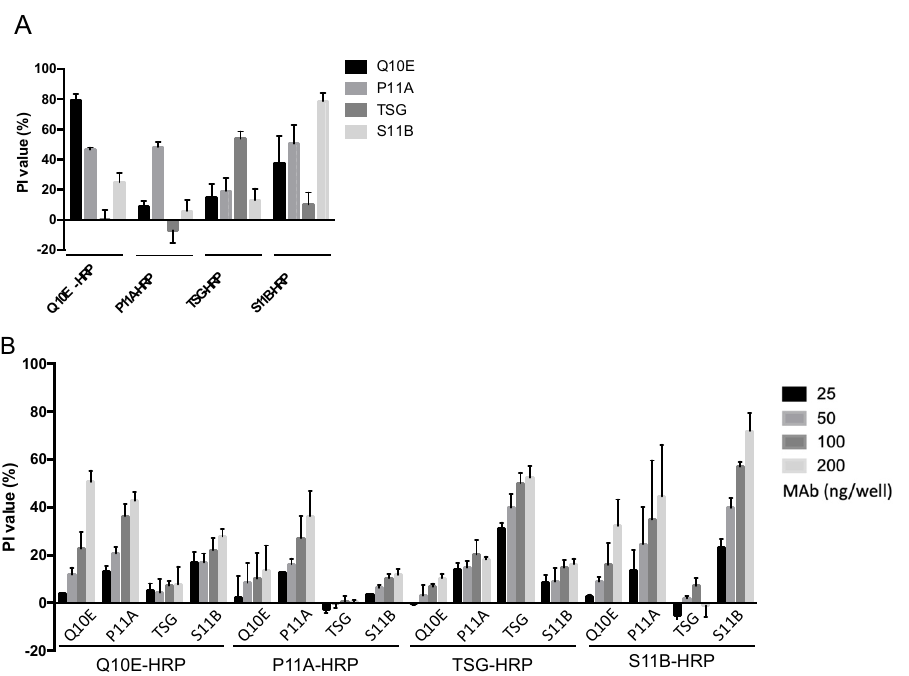
Figure 4. Steric effects between the four monoclonal antibodies (Q10E, P11A, TSG, and S11B). ( A ) The coated VLPs were blocked with non-conjugated monoclonal antibodies, including Q10E, P11A, TSG, and S11B at 400 ng per well, followed by 100 ng of the indicated conjugate. ( B ) The VLPs were blocked with different non-conjugated antibodies (25–200 ng per well), followed by 100 ng of conjugates. Each test was performed in triplicate.